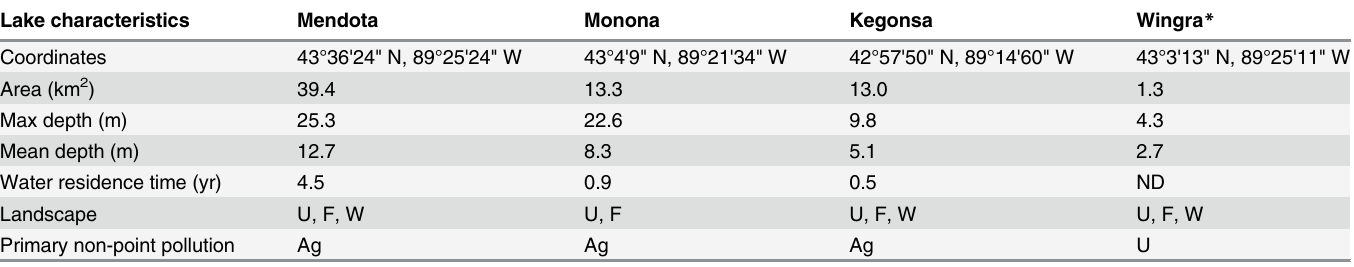
Table 1. Characteristics of four eutrophic lakes sampled: Lakes Mendota, Monona, and Kegonsa are directly connected via the Yahara River, while Lake Wingra is primarily fed by ground water and urban run-off and runs into Lake Monona. Lake characteristics